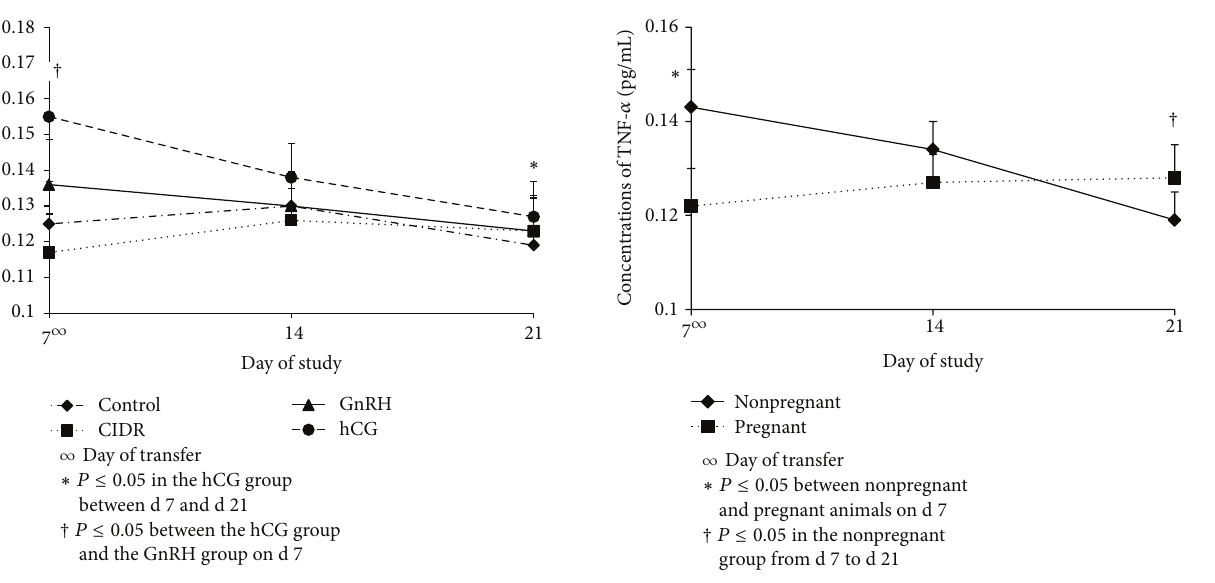
Figure 4: Concentrations (Mean ± SEM) of TNF- 𝛼 in pregnant and nonpregnant cows on d 7, d 14, and d 21. Pregnancy status 𝑥 day interaction (𝑃 ≤ 0.05) ; CIDR = controlled internal drug release; GnRH = gonadotropin releasing hormone; hCG = human chorionic